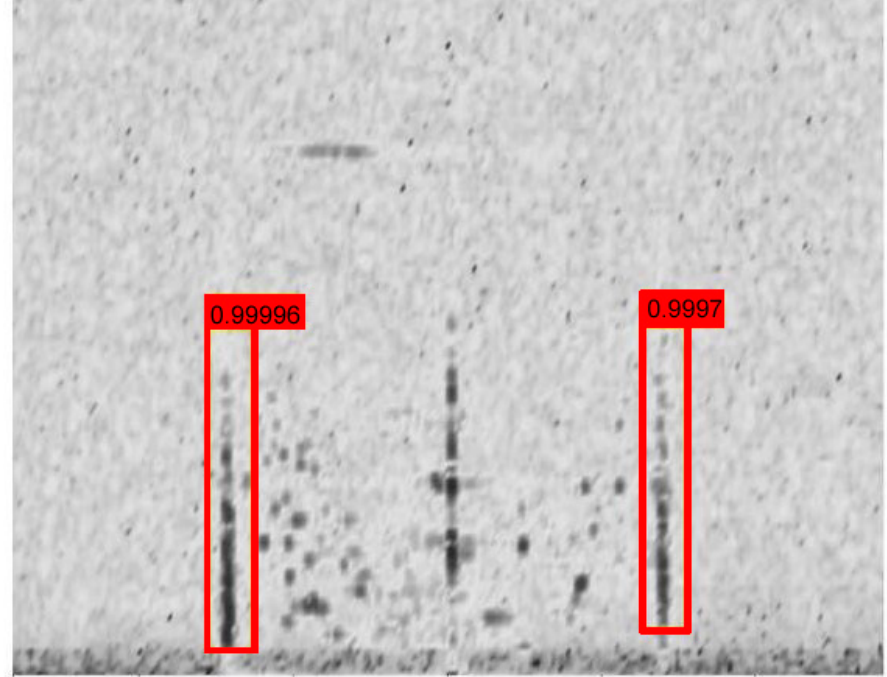
Figure 3. One example of the results of sea clutter detection with the scores.